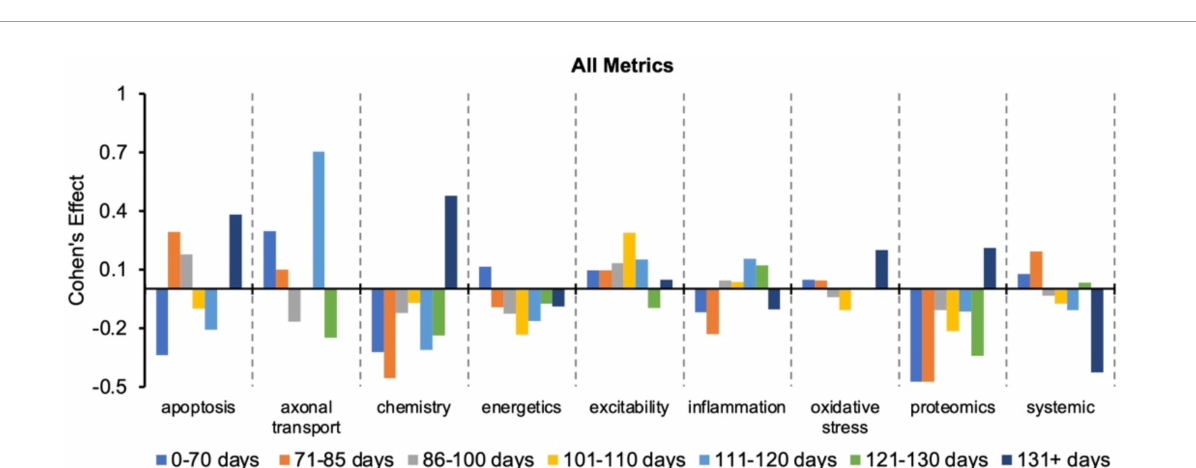
FIGURE2 Visualization of how the Cohen’s effect size, d , changes over time for each pathophysiological treatment category. No one pathophysiological category consistently performed better than the “all” treatments category (e.g., all pathophysiological treatment categories combined). Note that axonal transport is excluded in a few time bins due to inadequate sample size. Cohen’s effect is a statistical measure of each pathophysiological treatment category’s effect size for the specified time bin relative to the “all” treatments category of the corresponding time